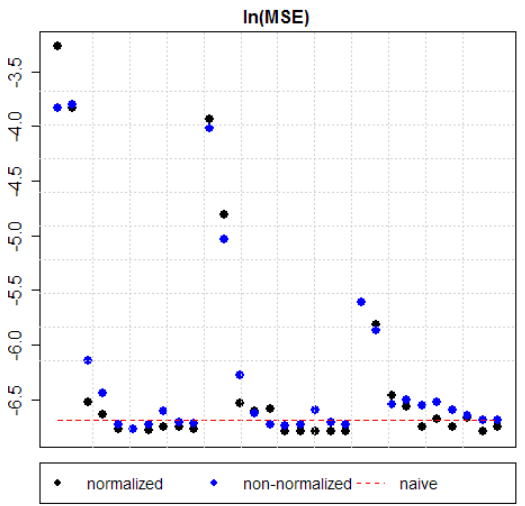
Figure 3. Prediction quality: ln(MSE) of normalized vs. non-normalized models.